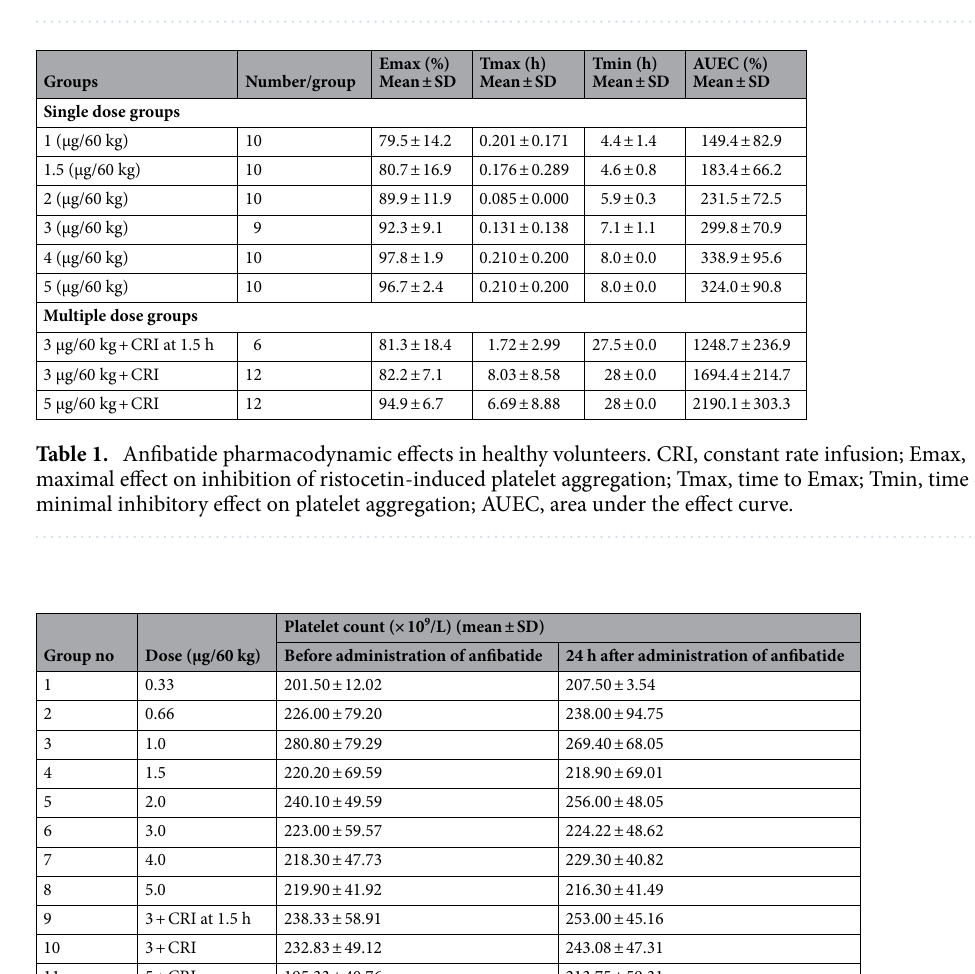
Table 2. Anfibatide did not significantly change platelet count. Platelet counts of each individual were measured before and 24 h after administration of anfibatide in single (Group 1–8, N = 8–9) and multiple dose groups (Group 9–11, N = 6–12). CRI, constant rate infusion; Mean ± SD.